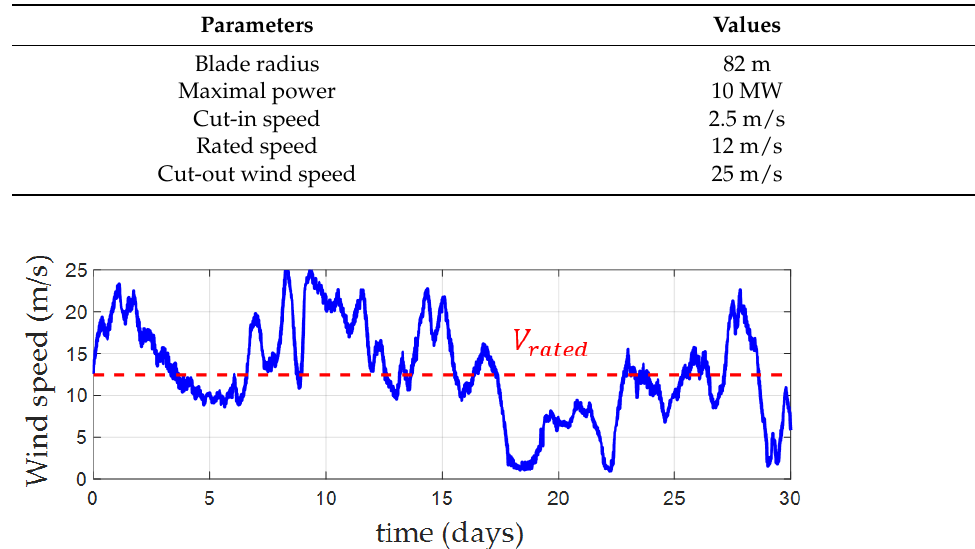
Table 1. Specifications of the considered wind turbine.